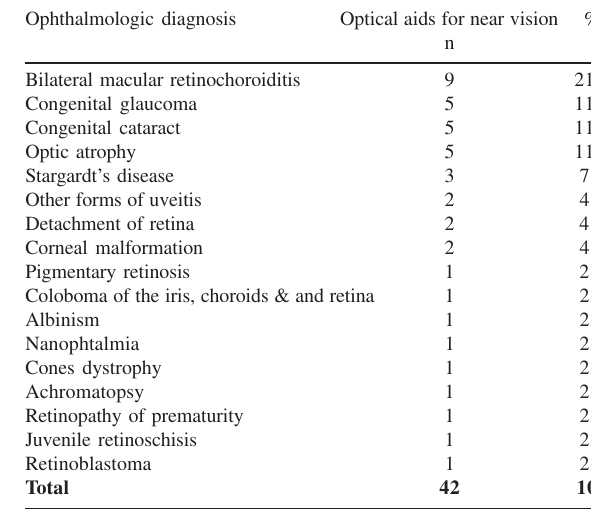
Table 6 - Distribution of prescribed optical aids for far distance by ophthalmologic diagnosis Ophthalmologic diagnosis Optical aids for distance